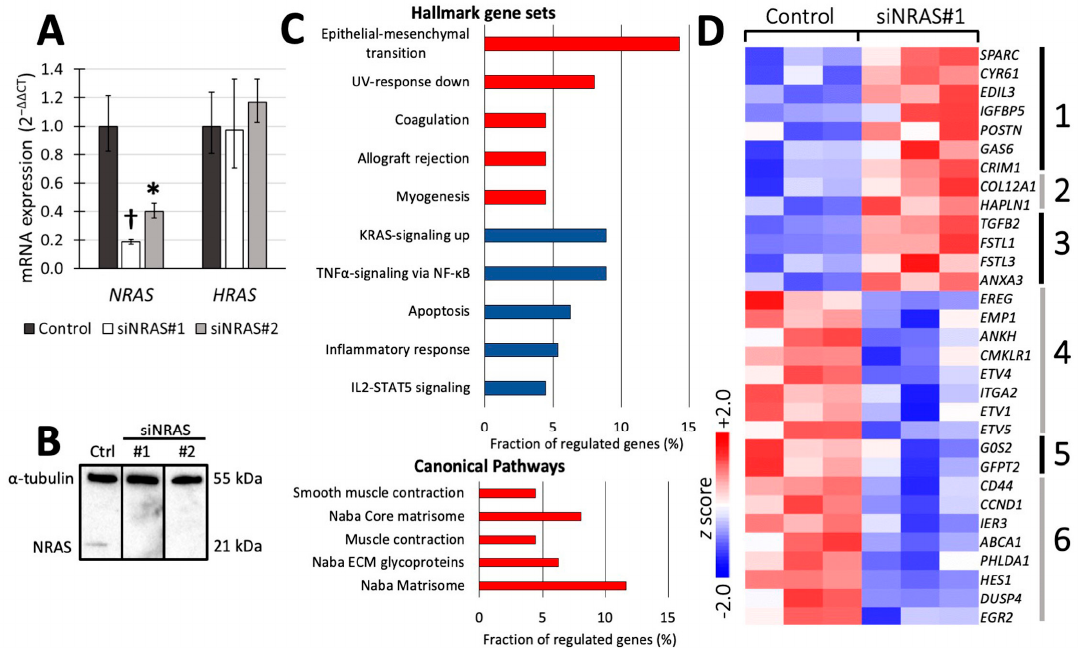
Figure 1. ( A ) and ( B ) Confirmation of efficient siRNA-mediated knockdown of NRAS expression (siNRAS) at mRNA ( A ) and protein ( B ) level with RT-qPCR and Western blot, respectively, at 72 h post transfection. Two siRNAs were used (siNRAS#1 and siNRAS#2; for sequences, see Materials and Methods). The expression of HRAS mRNA ( A ) was unaffected by siNRAS treatment, demonstrating its specificity. In ( A ), mRNA expression in control-transfected (dark-grey bars) and siNRAS-treated (white and light-grey bars) hPheo1 cells is presented as fold change (2 −ΔΔ CT ), with results from three independent experiments given as mean ± standard deviation, and p values calculated with student’s T -test indicated as * (0.001 ≤ p < 0.05) or † ( p < 0.001). In ( B ), representative protein blots from each condition (control (ctrl)); siNRAS#1 and #2 are shown. Alpha-tubulin serves as loading control. ( C )Top five significant gene sets upregulated (red) and downregulated (blue) in the Hallmark and Canonical Pathways set collections (upper and lower panel, respectively). ( D ) Heatmap displaying the z scores of the normalised expression level 2-logs for genes up- or downregulated by siNRAS#1 treatment and belonging to the gene sets Naba matrisome (groups 1 − 3), Naba core matrisome (groups 1 − 2), Naba ECM glycoproteins (group 1), Naba matrisome-associated (group 3), Hallmark KRAS-signalling up (groups 4 − 5), and Hallmark TNF α signalling via NF- κ B (groups 5 − 6). Results from three independent experiments are displayed.